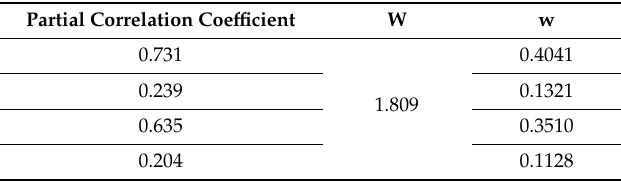
Table A2. Partial Correlation Coe ffi cient.